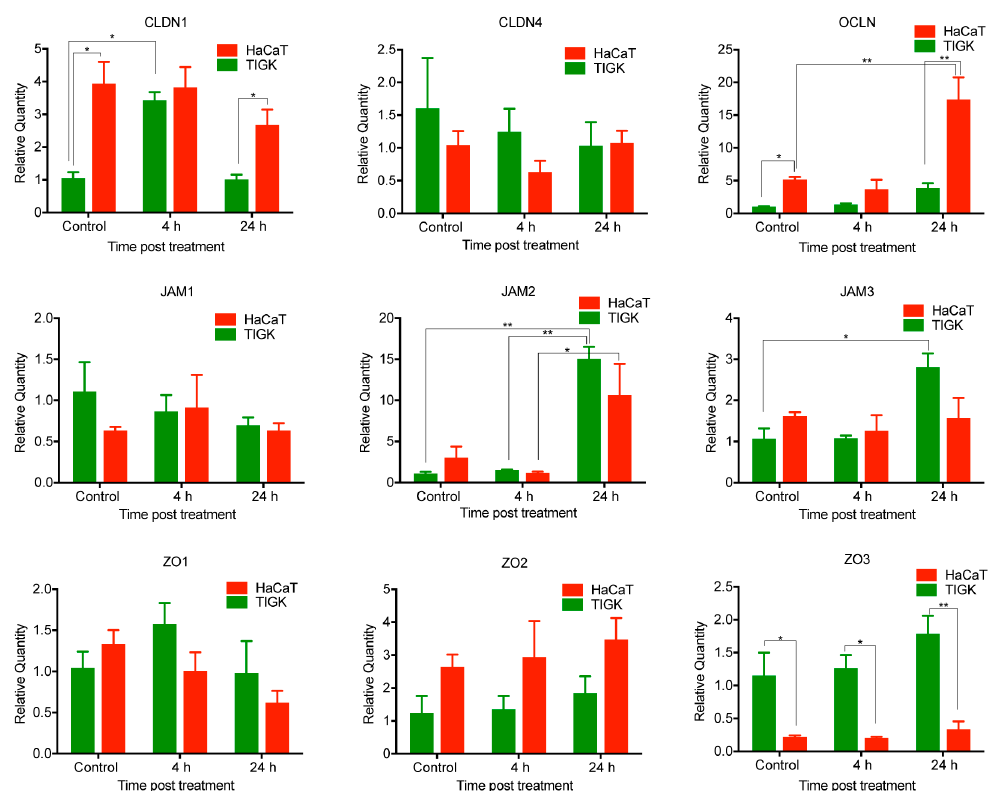
Figure 4. Differential expression of tight junction molecules after lipopolysaccharide (LPS) treatment in skin and oral keratinocytes. HaCaT and TIGK cells were cultured in a 12-well culture plate. The cells were treated with LPS (100 ng/mL) when reaching 80% confluency. mRNA expression of CLDN1, CLDN4, OCLN, JAM1, JAM2, JAM3, ZO1, ZO2 , and ZO3 was examined at 4 and 24 h after treatment by Real-Time PCR. Control: untreated. n = 3 replicates, * p < 0.05, ** p < 0.01.